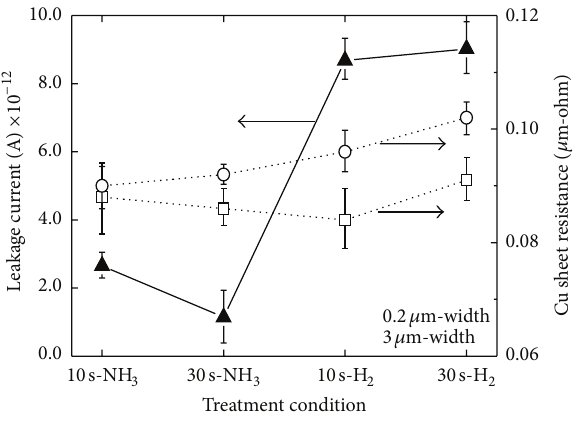
Figure 10: Sheet resistance of Cu lines and leakage current between Cu lines after various plasma treatment